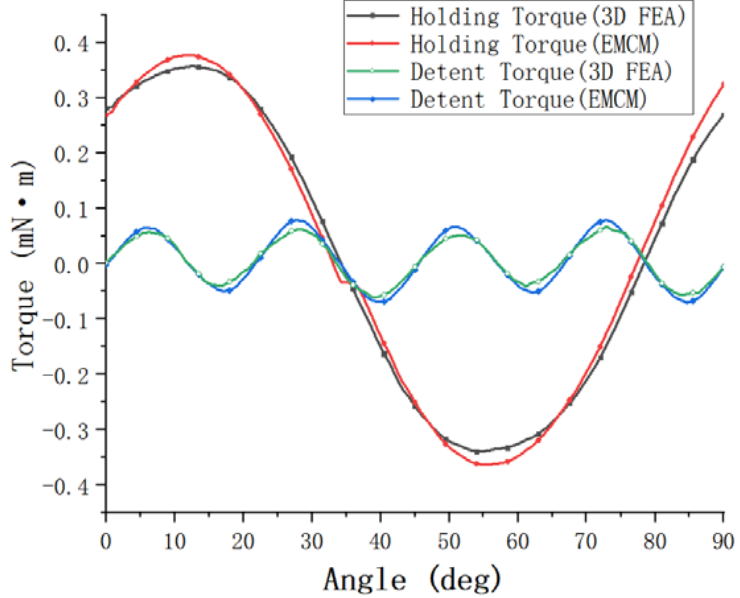
Figure 7. Equivalent magnetic circuit modeling.